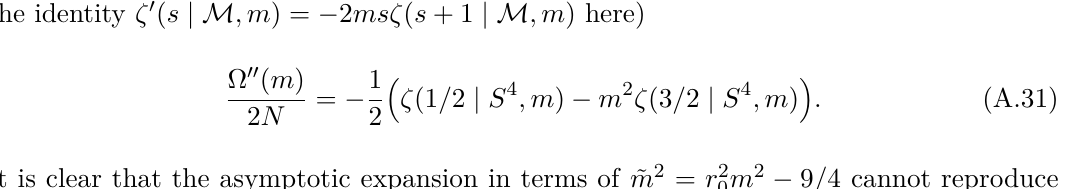
Flex from large